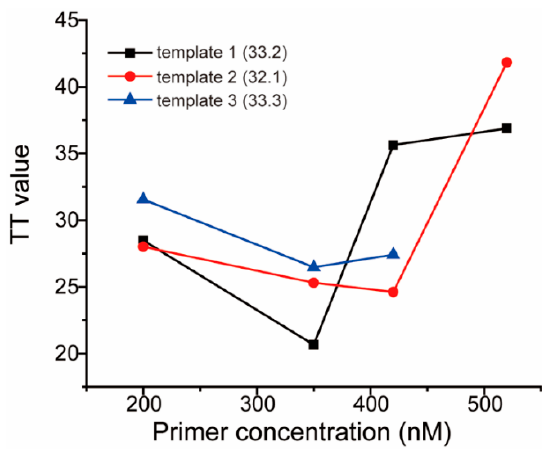
Figure 2. Optimizing the concentrations of the primer pair.